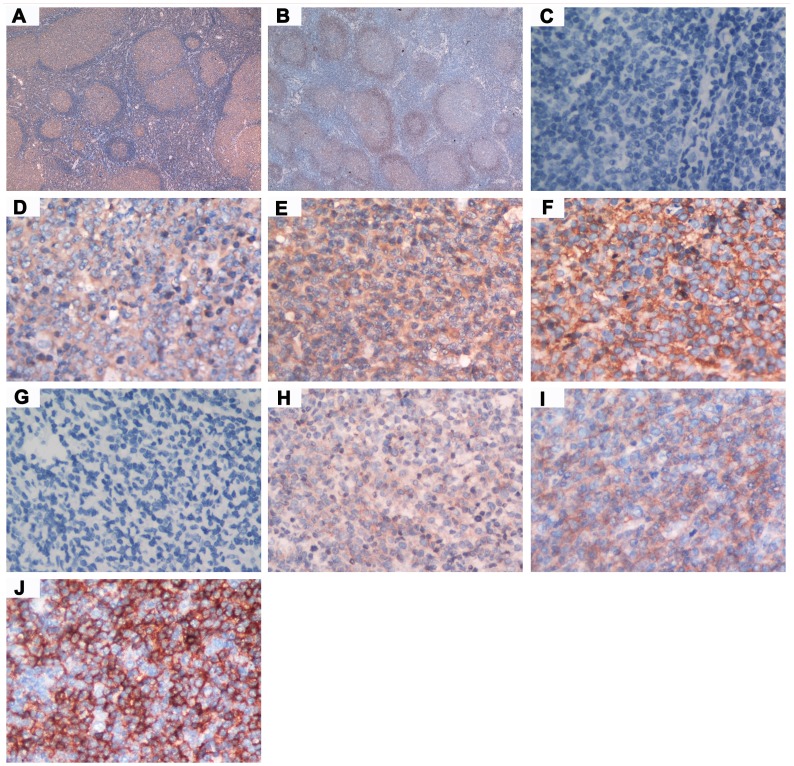
Typical distributions of BAFF and BAFF-R expression in follicular lymphoma (FL) and representative cases with different immunostaining intensity for BAFF and BAFF-R.(A) Distribution of BAFF expression in tumor specimen of FL. (B) Distribution of BAFF-R expression in tumor specimen of FL. (C) Negative staining (−) for BAFF. (D) Weak staining (1+) for BAFF. (E) Moderate staining (2+) for BAFF. (F) Strong staining (3+) for BAFF. (G) Negative staining (−) for BAFF-R. (H) Weak staining (1+) for BAFF-R. (I) Moderate staining (2+) for BAFF-R. (J) Strong staining (3+) for BAFF-R.